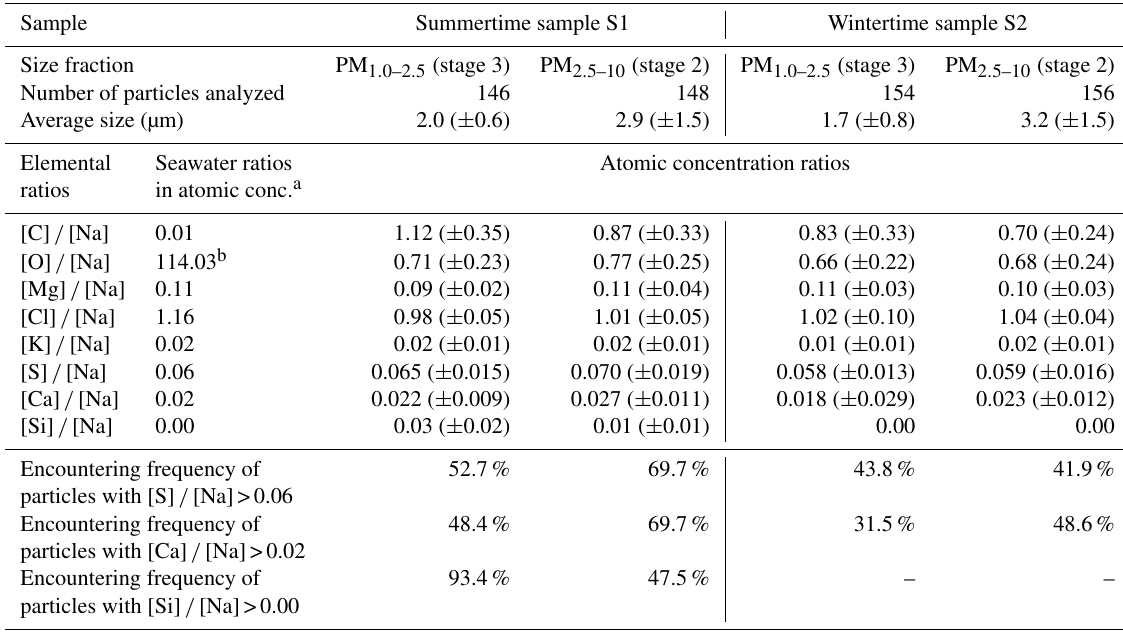
Table 1. Atomic concentration ratios of the chemical elements to Na for individual particles in the summertime and wintertime PM 2 . 5–10 and PM 1 . 0–2 . 5